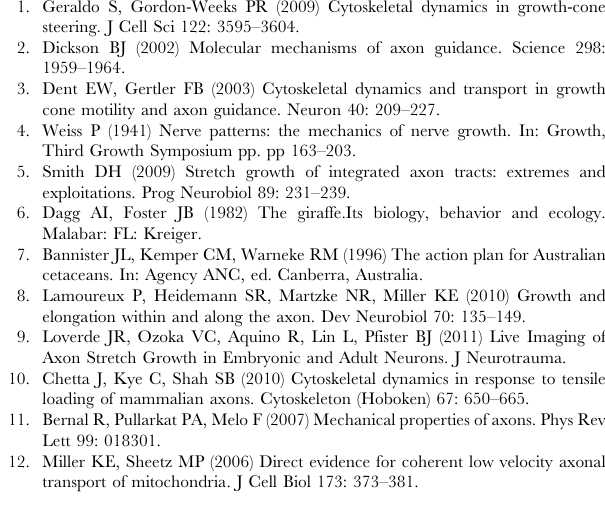
mCD8-GFP did not display any apparent defects in mushroom bodies in L3 brains. Arrowheads point to the MB neurons. (C, D) 807-GAL4 . UAS-mCD8-GFP showed that VUM neurons were present in brv 1 mutants (arrowheads). Two consecutive abdominal neuromeres (dashed lines) are shown. A–D represent maximum projections of Z-stacks. Bar: 20 m m. (TIF) Figure S6 Peripheral glia spacing and distribution is not affected in brv mutant larvae. (A) Labeling of L3 larva brains from brv + and brv 1 mutants with anti-Repo antibody shows a similar spacing between glia in the peripheral nerves. (B) Nrv2-GAL4 . GFP expression in L3 larva brains from wild-type ( brv + ) and brv 1 mutants. (C) Merged frames of anti-Repo (red) and Nrv2- GAL4 . GFP (green). (D) Histograms depicting the average number of glial cells in comparable stretches of the most posterior peripheral nerves of brv + and brv 1 (n =30 for each) larvae. Bar: 50 m m. (TIF) Figure S7 Rescue of brv mutants by expression of GlcAT-P using UAS/GAL4 system. Quantification of the length of the L3 VNCs (A) and peripheral nerves (B) in different rescue experiment settings is provided (*: p , 0.0001).